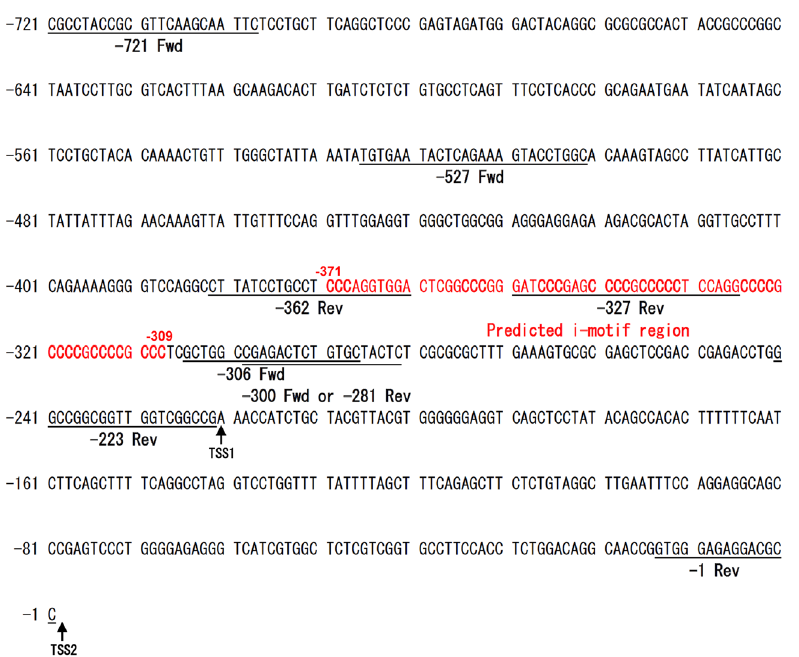
Figure 1. TARDBP upstream sequences from the UCSC genome browser. The 721 nucleotides in the TARDBP upstream sequence include the predicted promoter region shown in a previous study. The red characters indicate the predicted i-motif region. Cytosine-rich regions are denoted by bolded text. The primer sequences used to generate the promoter/reporter constructs are underlined. Fwd forward primer, Rev reverse primer, TSS transcription start site. The UCSC genome browser shows 2 TSSs, and TSS1 is located 223 bp upstream of